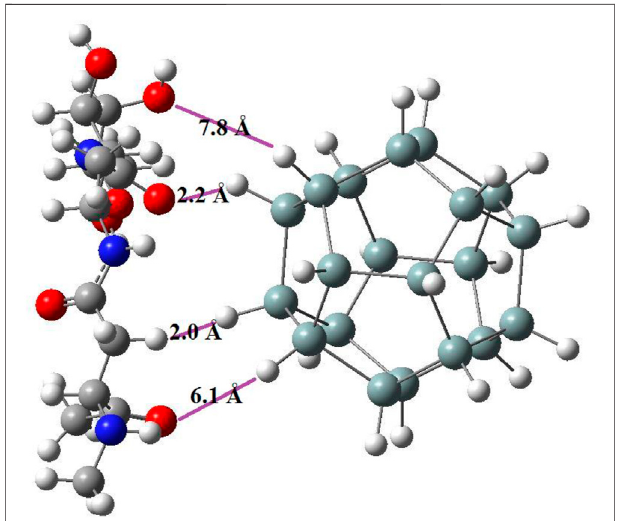
FIGURE 9 | Van der Waals interactions are established between the Si 20 H 20 and N- and O-Link glycoproteins, the absorption in the new system also enters the visible